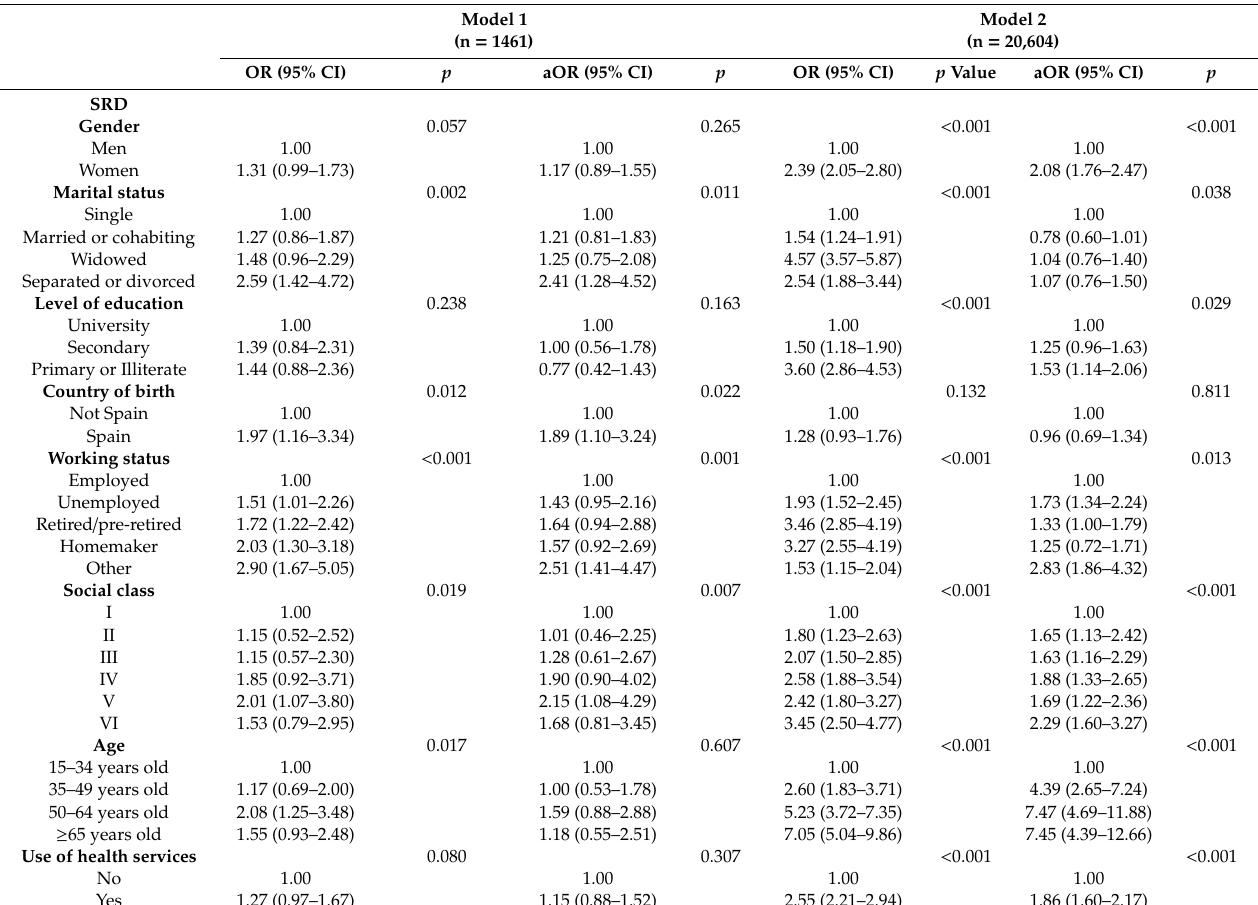
Table 3. Association of sample characteristics with being positive on the SRD items among PHQ-8 positives (model 1) and being negative on the SRD items among PHQ-8 negatives (model 2). European Health Interview Survey in Spain, 2014 /